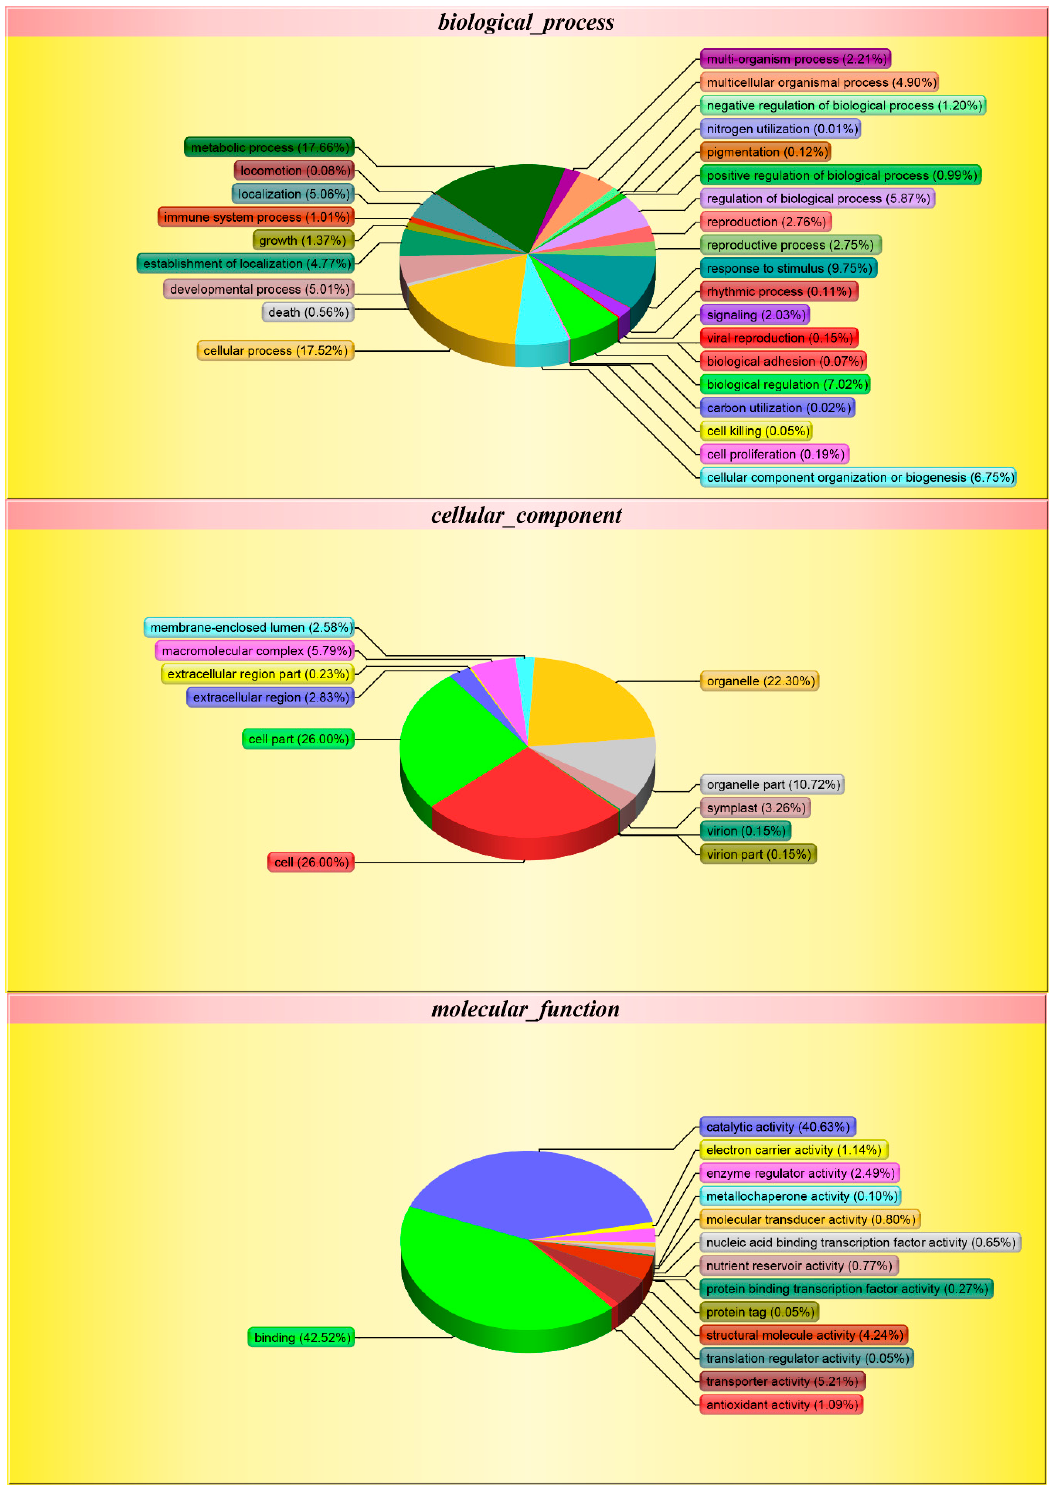
Figure 4. Gene ontology (GO) classification of the Differentially Expressed Proteins (DEPs) between S 727 and S3057.